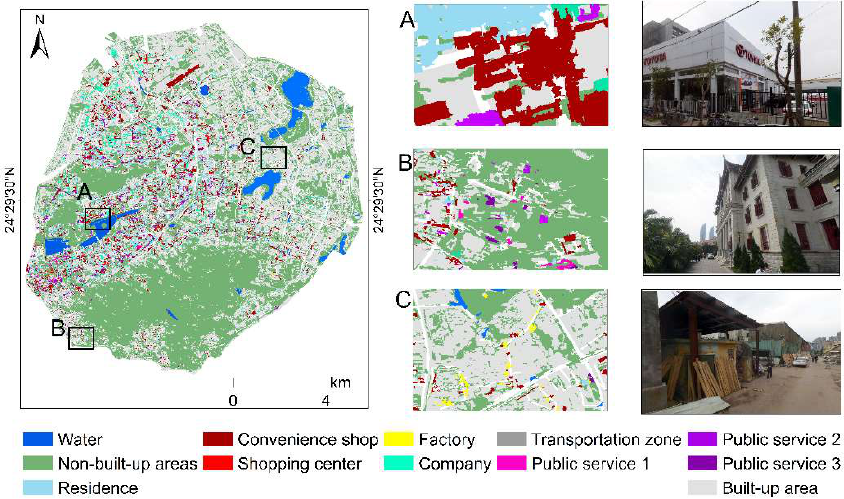
Figure 5. The functional segment identified by the POI and weight coefficients and detailed information; A. The convenience shop zone: the car sales area. B . The public service zone: campus of university C . Factory.